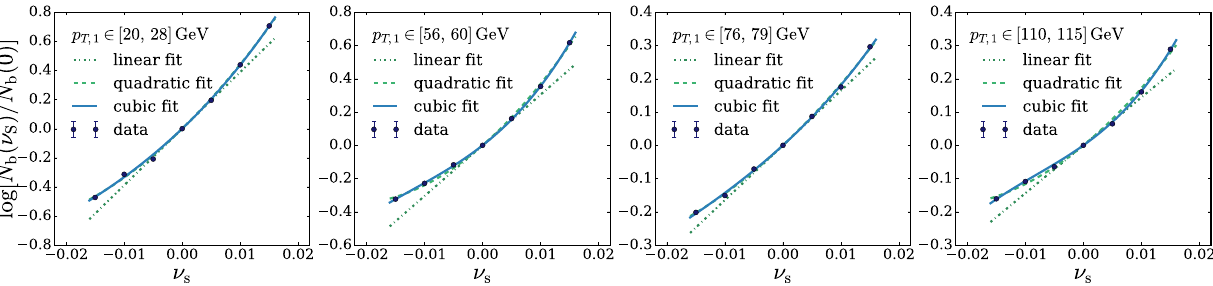
Fig. 12 Thepercentilesoftheempirical ¯ t distributionasafunctionofthetrainingepochs(toprow)andthedistributionoftheempirical ¯ t distribution after 1M training epochs (bottom row) for the ( 5 , 10 , 10 , 10 , 1 ) network at different values of the weight clipping